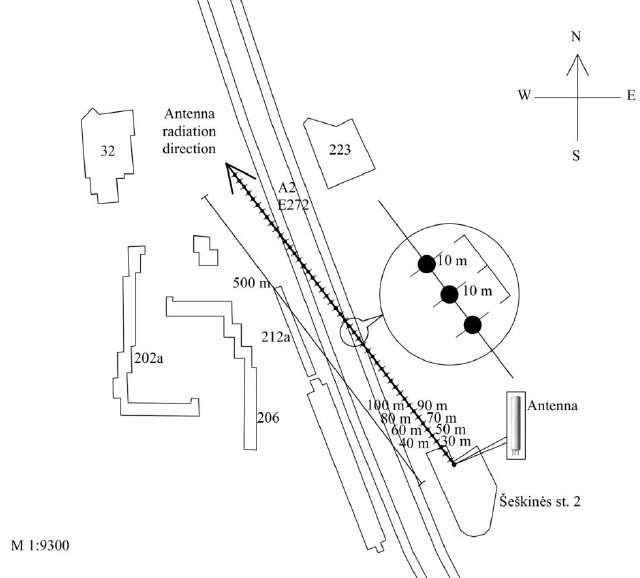
Figure 2. Measurement scheme of electromagnetic power density of the mobile telephony base station antenna (ERP = 1739 W).